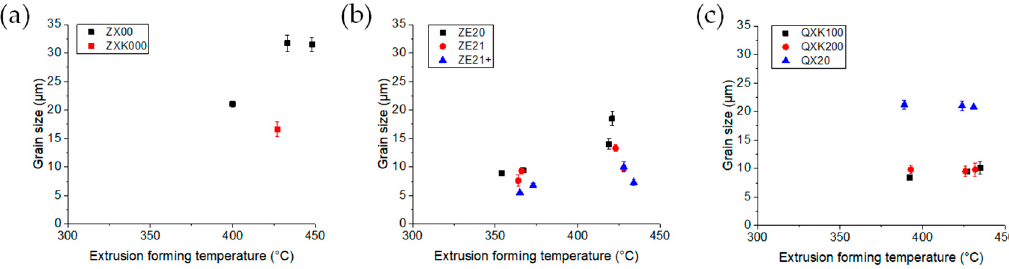
Figure 10. Average grain size correlation to the extrusion forming temperature (measured in the die): ( a ) ZX-series alloys, ( b ) ZE-series alloys, and ( c ) QX-series alloys.